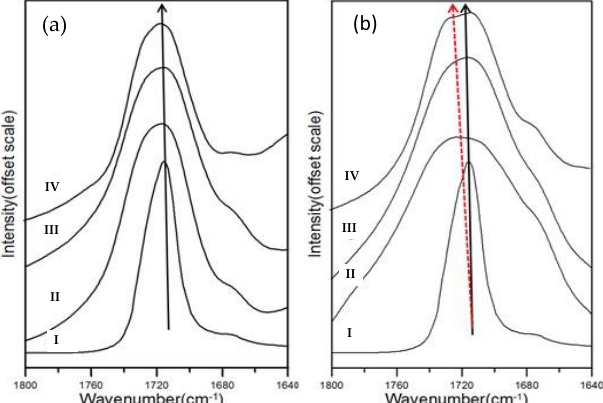
Figure 8. Deconvoluted IR absorbance peaks in the carbonyl-stretching region for phenoxy/PBT (9/1) after isothermal treatment at 260 °C for various periods of time: ( a ) 5 min, ( b ) 20 min, and ( c ) 90 min. 1713 cm -1 1724 cm -1 Figure 9. Mole fraction of specimens vs. heating time for phenoxy/PBT (9/1) at 260 °C. 3.3. Effect of Chemical Interactions on Crystallization Behavior In reactive blends, the progressive exchange reaction results in the transformation of the initial homopolymers into block copolymers and finally into random copolymers. The formed copolymers influence the miscibility of the blends. Exchange reactions also influence the crystallization of semicrystalline polymers in the blends. The transition to block or random copolymers decreases the crystallinity because of the dissimilarity of the copolymer chemical units [23,30]. In this work, the